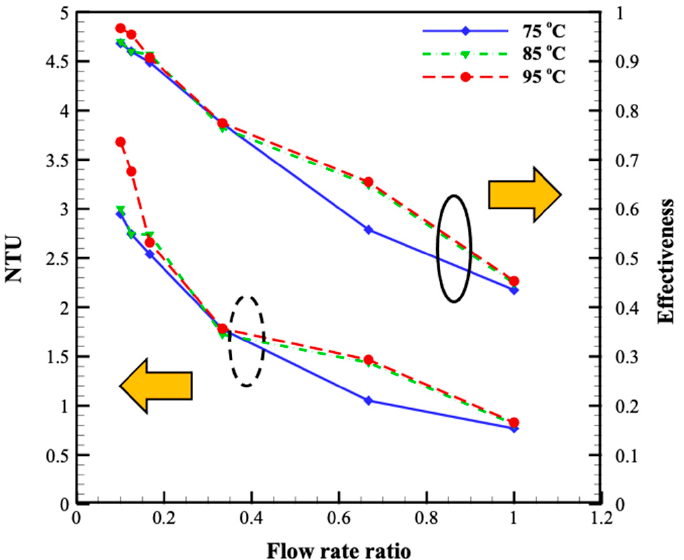
Figure 9. The profiles of NTU value versus the flow rate ratio.